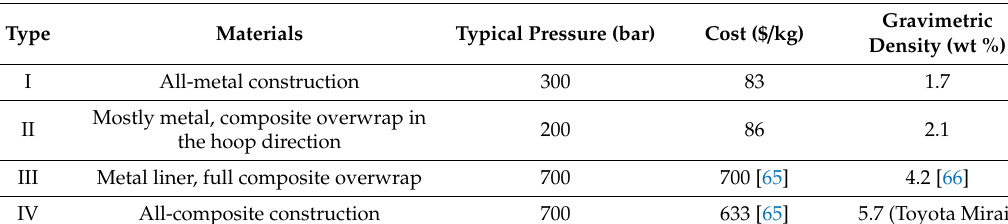
Table 3. Pressure vessel materials according to their type.